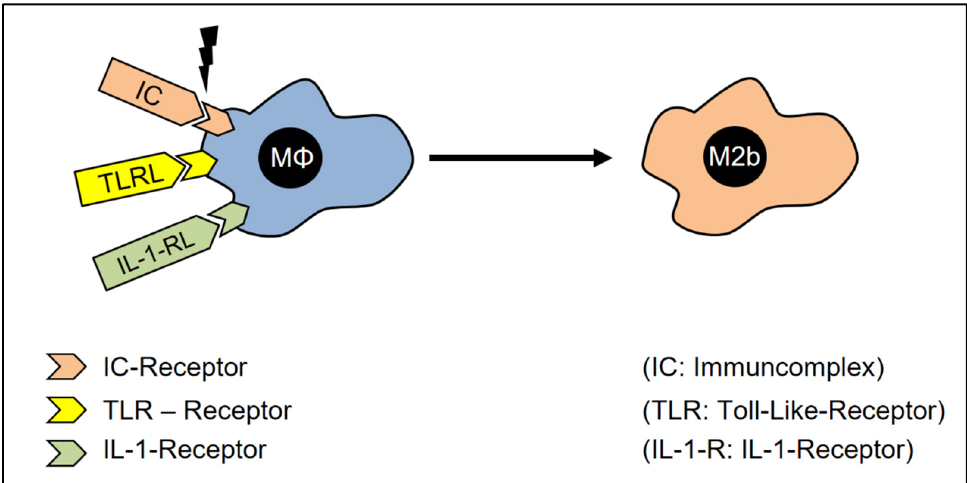
Figure 7. The polarization of M2b-Macrophages. In the presence of immune complexes, TLR-ligands, and IL-1 receptor ligands, the macrophages adopt the M2b phenotype.